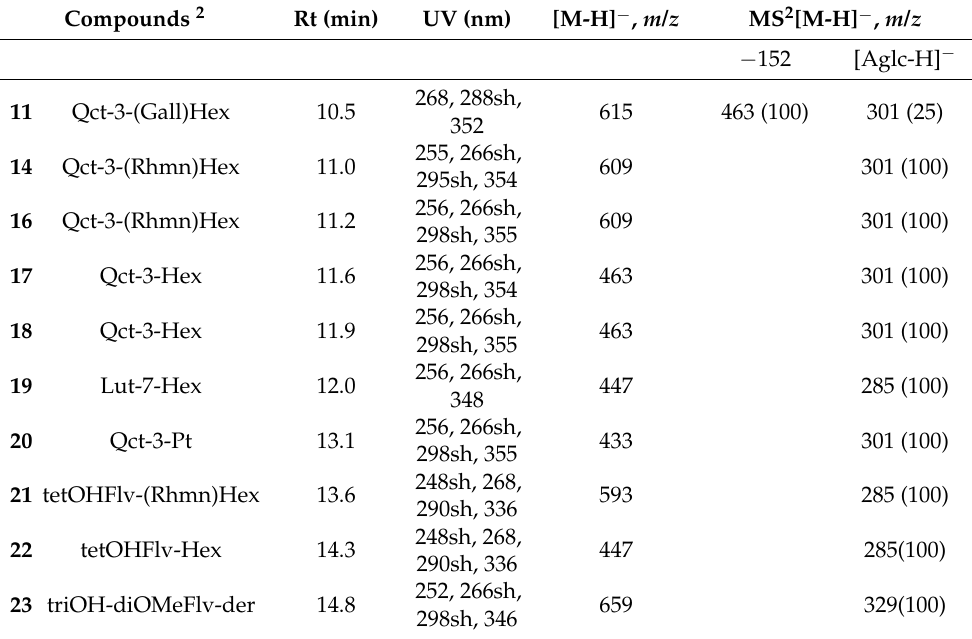
Table 2. Rt, Molecular Formula, [M-H] − and MS 2 [M-H] − data for flavonoids derivatives detected in methanolic extracts obtained from A. chilensis leaves 1